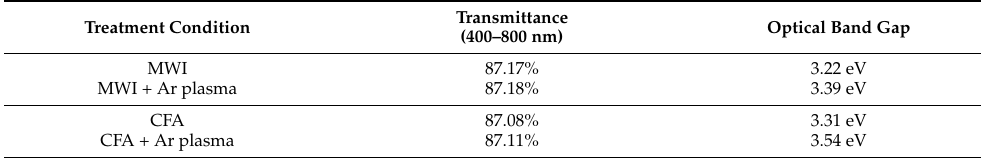
Figure 7. ( a ) Optical transmittance spectra of MWI ITO films; ( b ) optical band gap calculated using optical absorption coefficient. Table 1. Optical properties of sol–gel ITO thin films according to treatment condition.